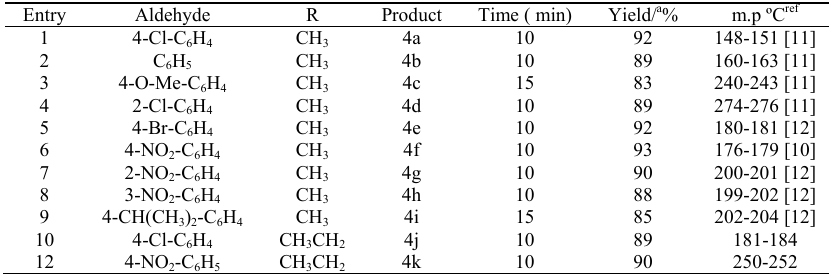
Table 2. Synthesis of 3,4,5-substituted furan-2(5H)-ones using nano-colloidal silica@APTPOSS (16 mg) under microwave irradiations (400 W) in ethanol